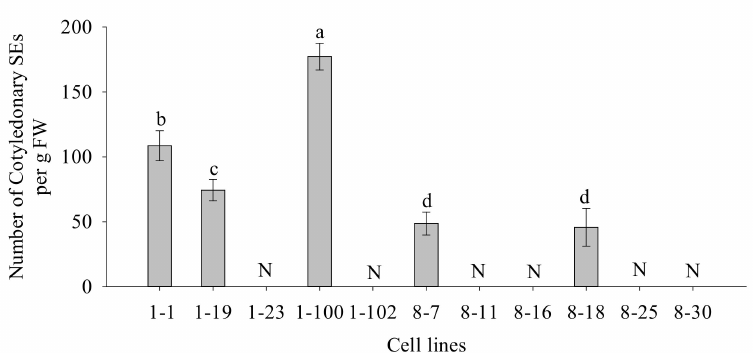
Figure 2. Number of cotyledonary SEs in different cell lines of P. koraiensis . Different letters above the columns indicate significant differences at the p < 0.05 level, and “N” indicates that the number of cotyledonary SEs was 0.